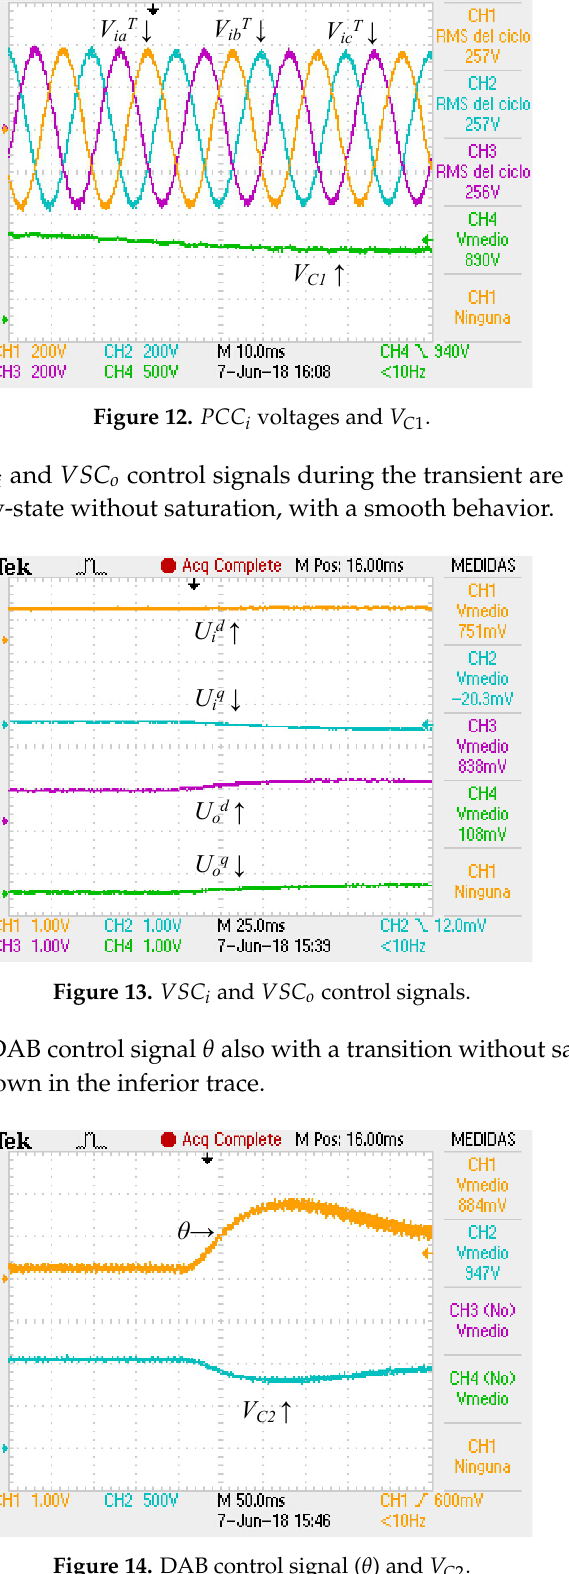
Figure 14. DAB control signal ( θ ) and V C 2